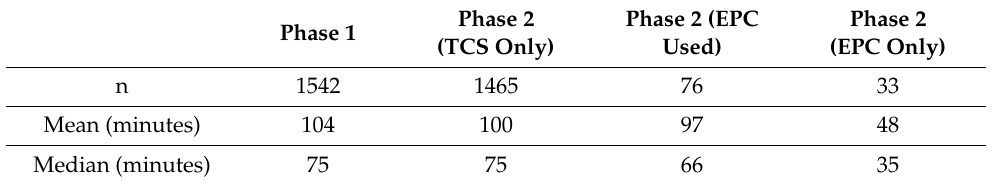
Table 12. Overall meal preparation